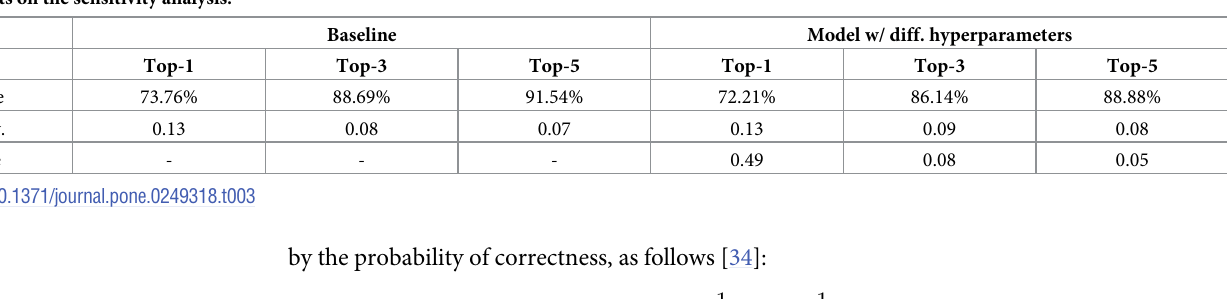
Table 3. Results on the sensitivity analysis.